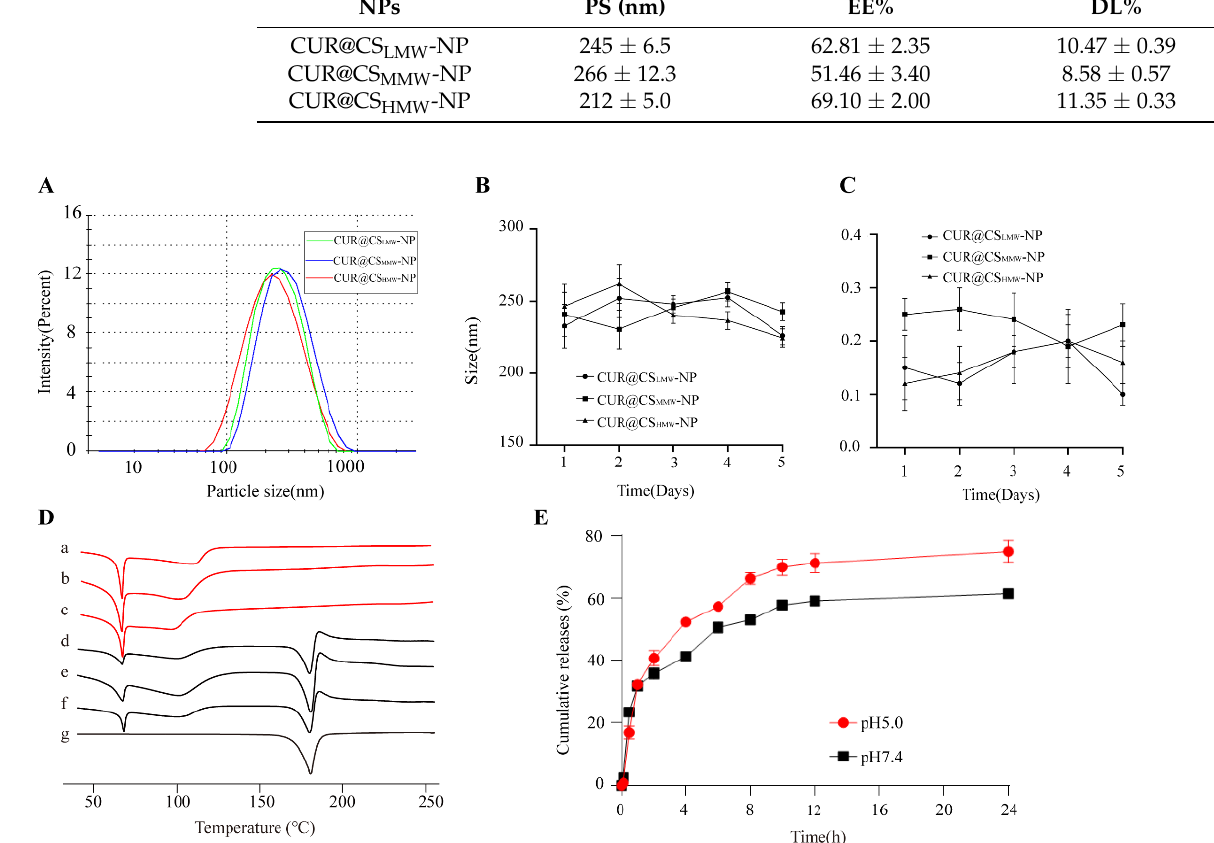
Figure 4. Characterization and in vitro drug release evaluation of CUR@CS-NP. ( A ) PS distribution